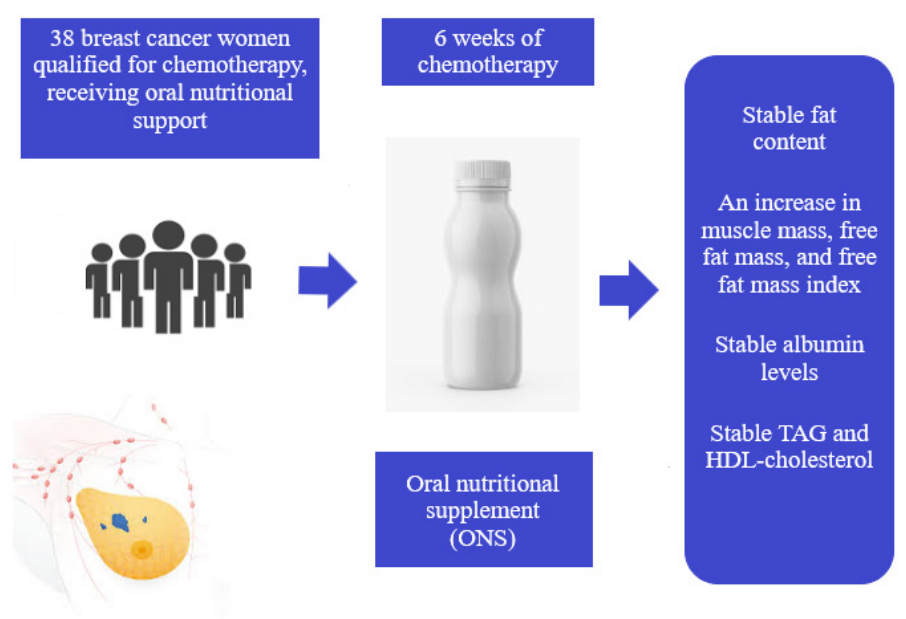
Figure 1. Scheme of the conducted research.